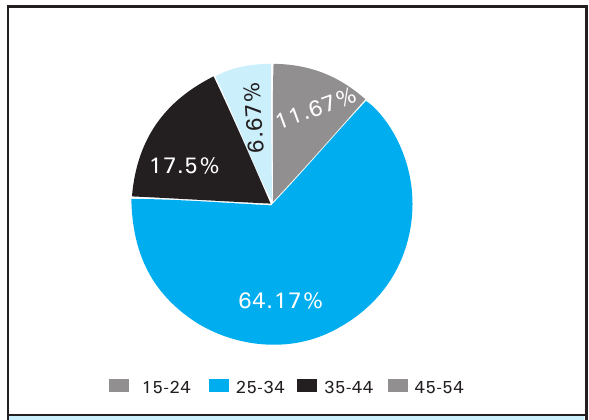
Figure 1. Age Distribution among clients.